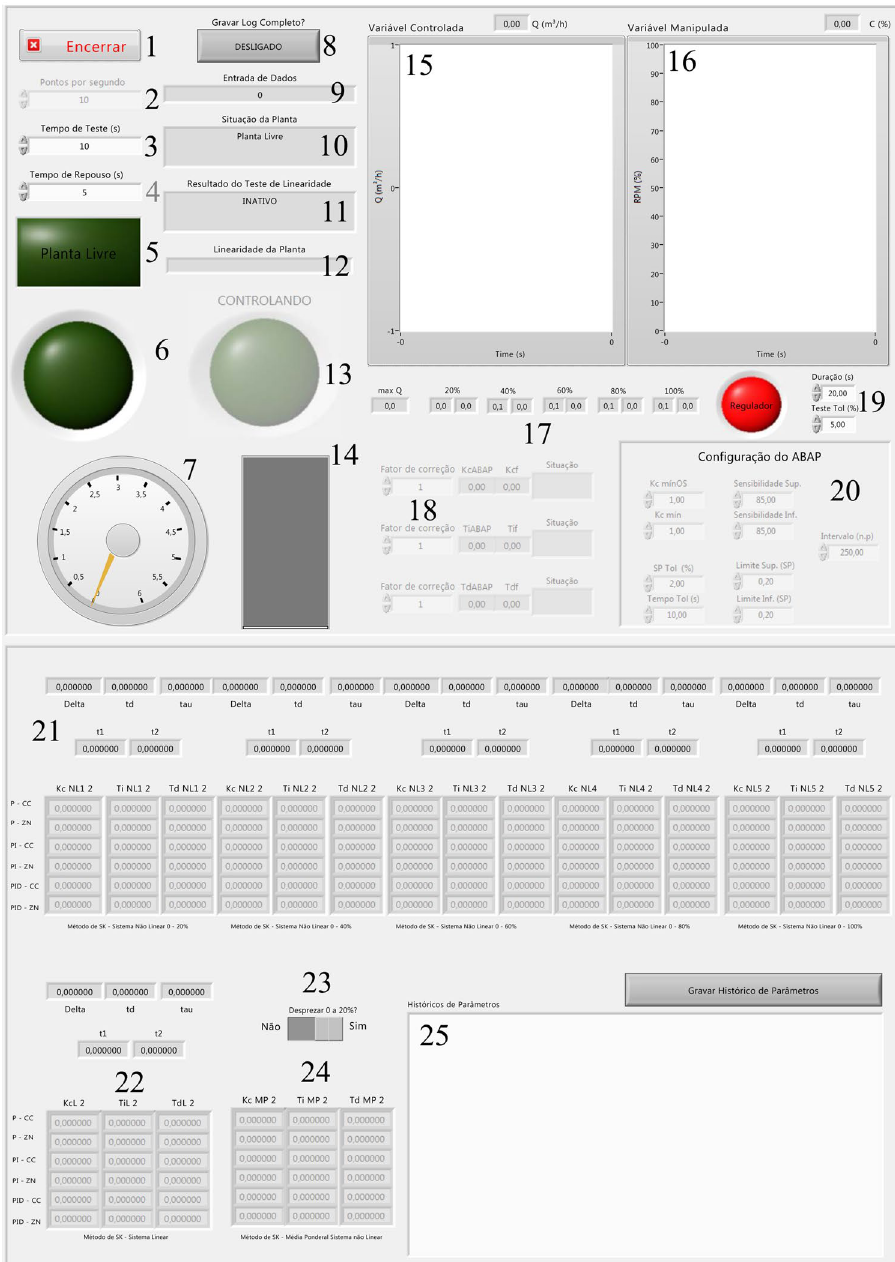
Fig. 5 Photograph of the slave HMI